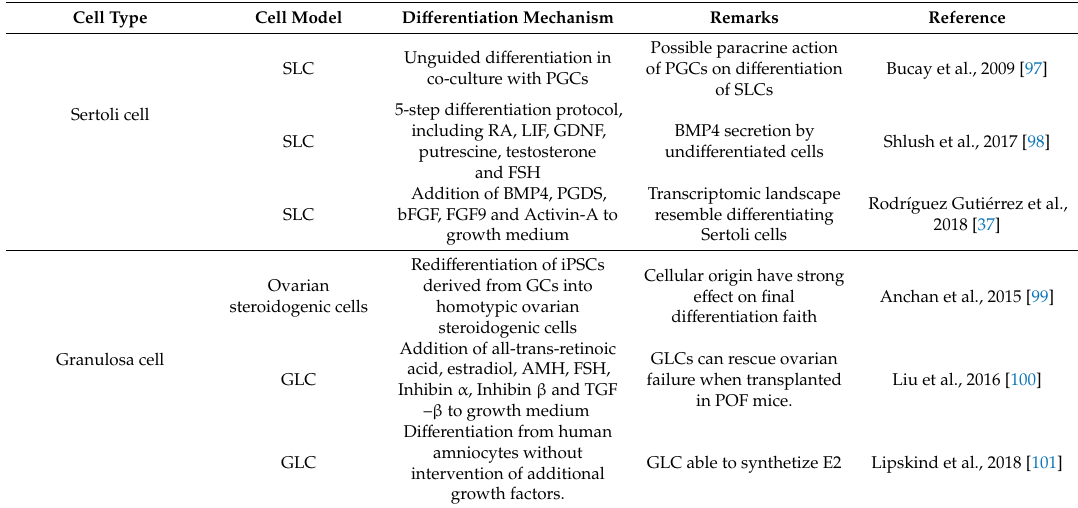
Table 1. Human PSCs-Derived Gonadal Cell